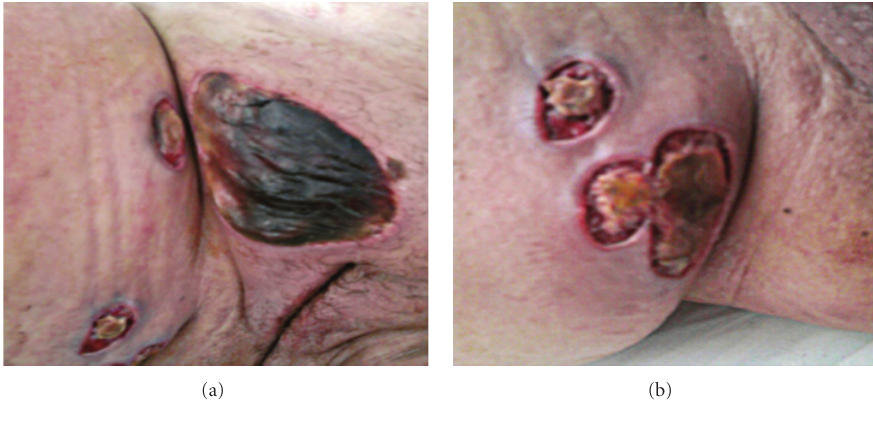
Figure 1: Skin necrosis in the d12 of induction daunorubicin-cytarabine.